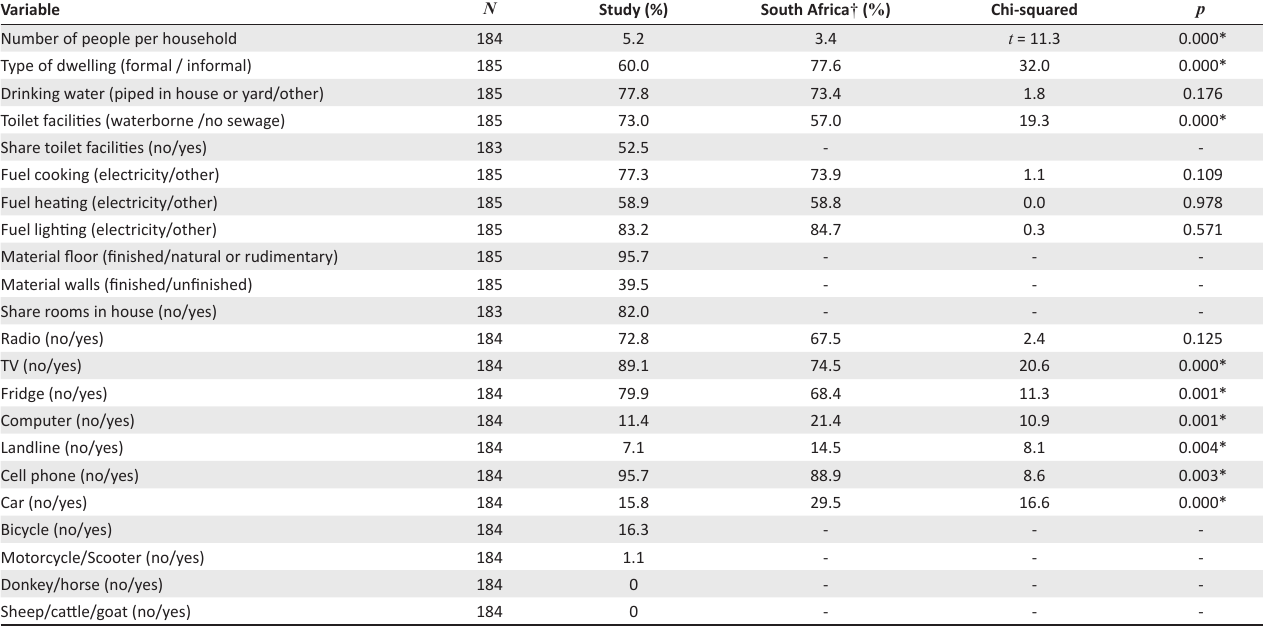
TABLE 5: Socio-economic status indicators and South African comparison.